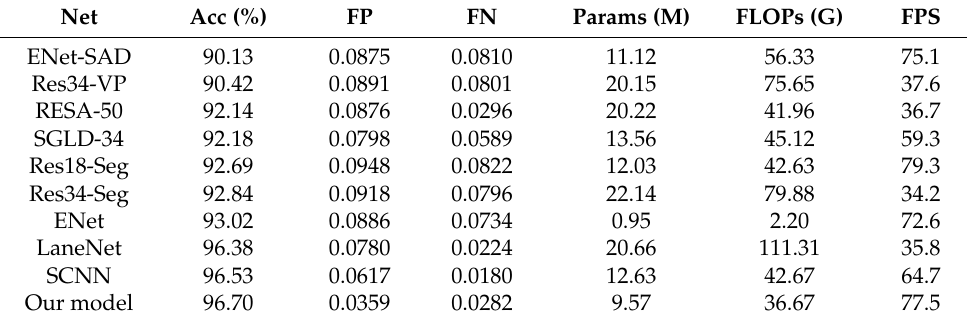
Table 3. Parameter settings of